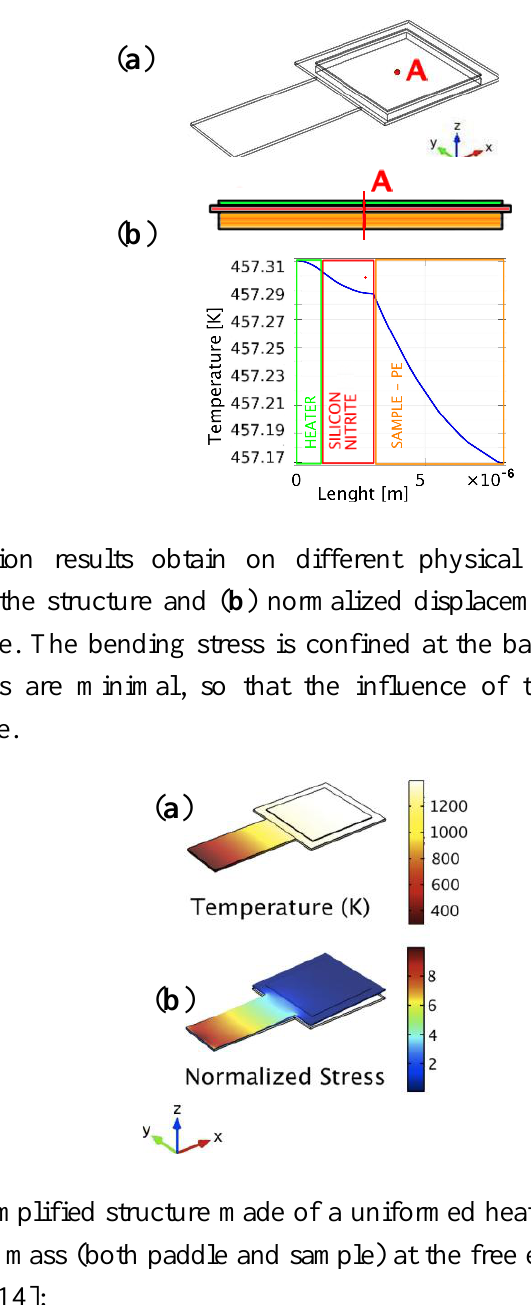
Figure 1. Representation of a cantilever-based TGA and temperature simulation results. ( a ) Model of the MEMS sensor realized by Comsol; ( b ) Cross-section temperature distribution on device under operation condition.